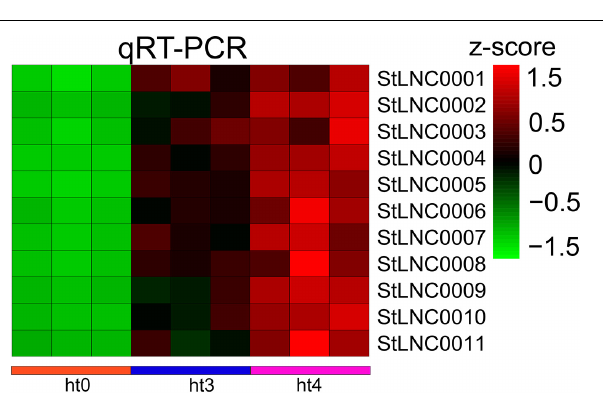
FIGURE 6 | Comparison of 11 specific DELs from cluster 2 expressions determined by RNA-seq and qRT-PCR. Relative transcript levels of the DELs were determined by qRT-PCR. Data is shown by a heat map with z